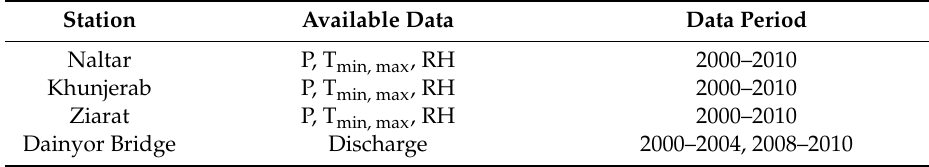
Table 2. Hydro-meteorological data available for the Hunza basin 2000–2010.